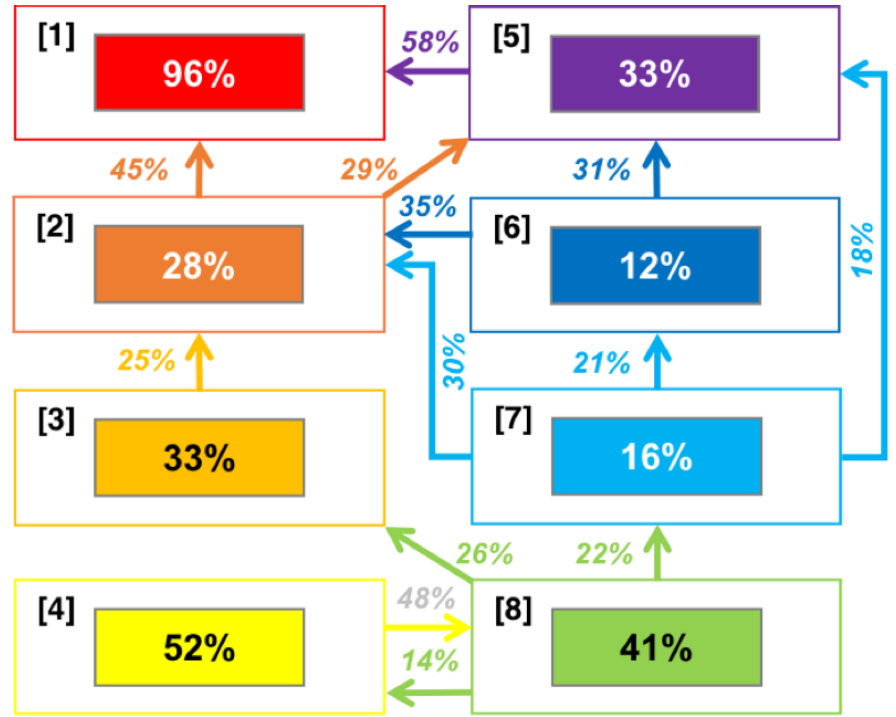
Figure 7. Pathways of cluster changes between 2016 and 2022. Value at the centre of each box corresponds to the proportion of the cluster’s population that remained the same between 2016 and 2022. Coloured arrows show the proportion of the population of a given cluster in 2016 that transitioned to a new cluster in 2022 (e.g., 45% of all residents belonging to cluster 2 in 2016 changed to cluster 1 in 2022). Pathways with frequencies <10% are not shown.